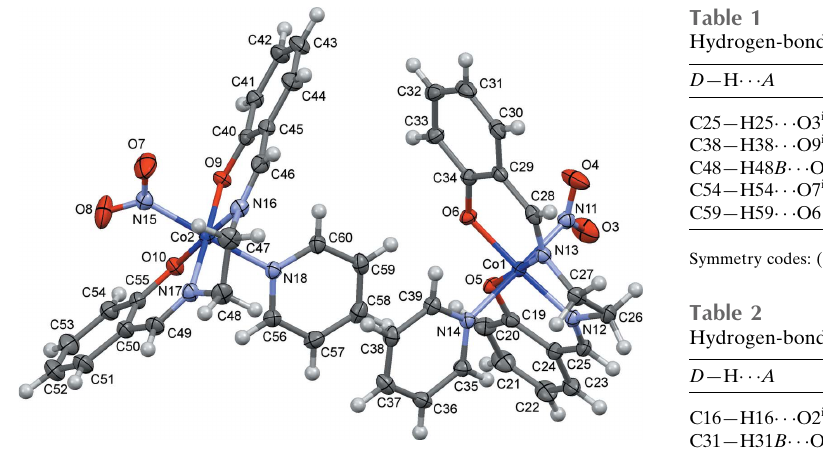
Figure 1 The molecular structure of (I), showing displacement ellipsoids at the 30% probability level.